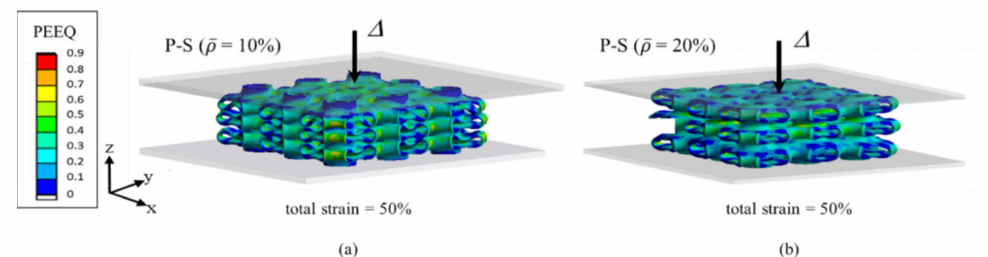
Figure 18. Equivalent plastic strain (PEEQ) contour plots at 50% deformation P-S with: ( a ) ρ = 10% and ( b ) ρ = 20%.